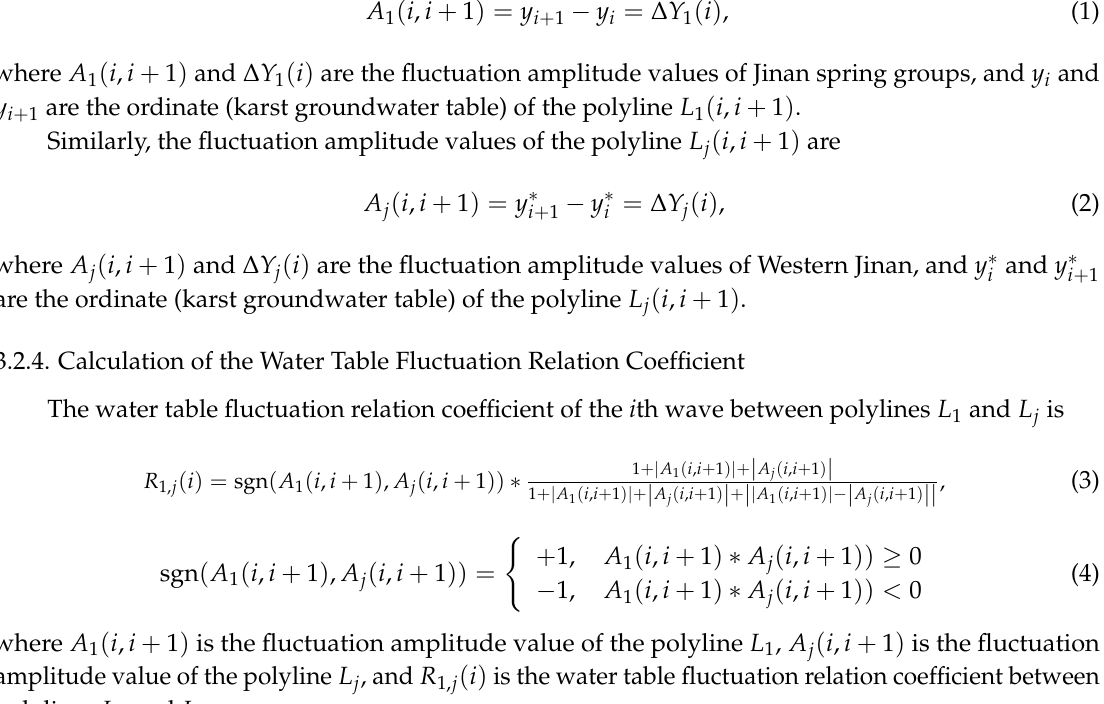
Figure 5. Relationship between the polyline coordinate and the fluctuation amplitude values. Likewise, the time sequence X corresponds to time series values Y j = ( y ∗ ) to structure a polyline L connecting each point ( x i , y ∗ i system (Figure